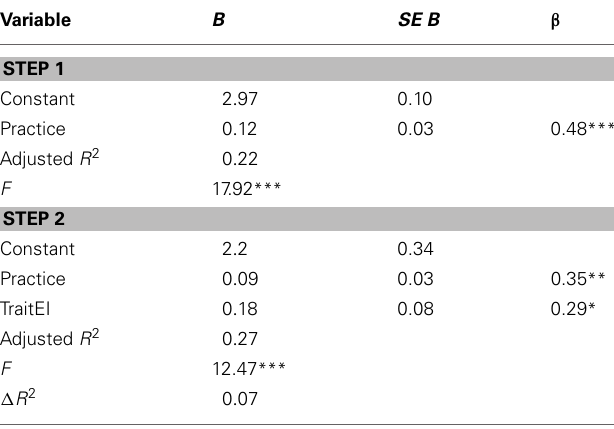
Table 4 | Summary of stepwise regression analysis for six variables predicting flow in piano performance students ( N =